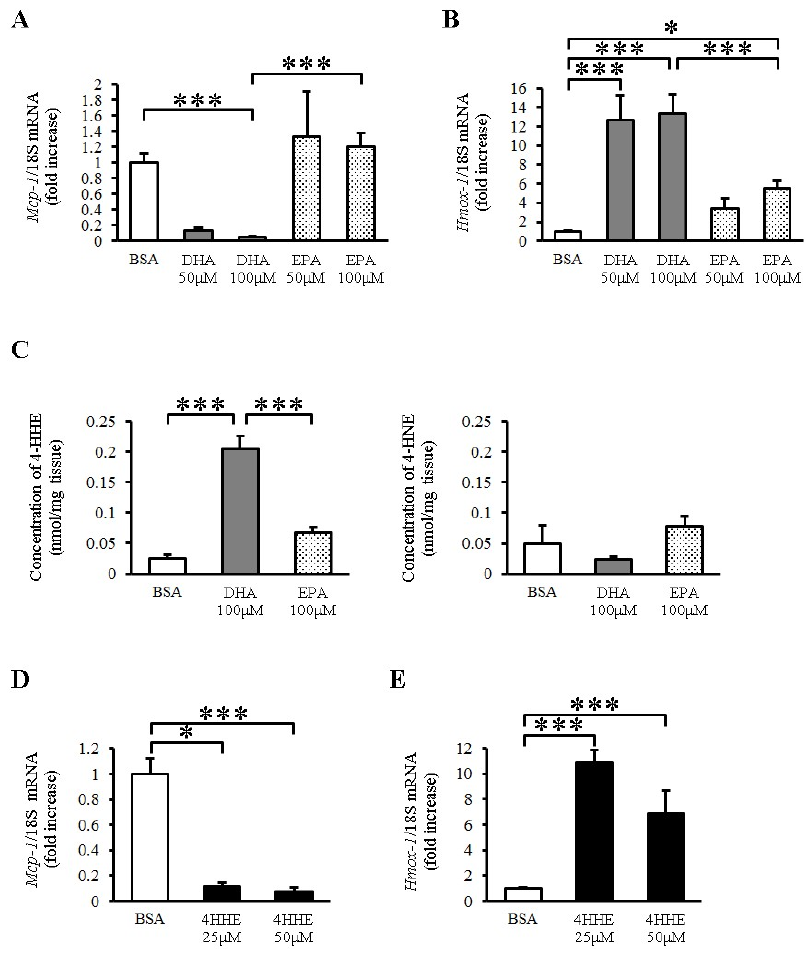
Figure 1. Docosahexaenoic acid (DHA)-derived DHA generated 4-hydroxy hexenal (4-HHE) inhibits the expression of Mcp-1 Messenger RNA (mRNA), but induces heme oxygenase 1 ( Hmox-1 ) mRNA in rat aorta. Rat arterial strips were treated with bovine serum albumin (BSA), DHA (50–100 µ M), EPA (50–100 µ M) or 4-HHE (25–50 µ M) for 6 h under ex vivo conditions. ( A , B ) Relative mRNA expression of Mcp-1 ( A ) and Hmox-1 ( B ) in arterial strips was quantitated using the real-time quantitative polymerase chain reaction (RT-qPCR). Results were normalized against 18S rRNA and expressed as fold increase